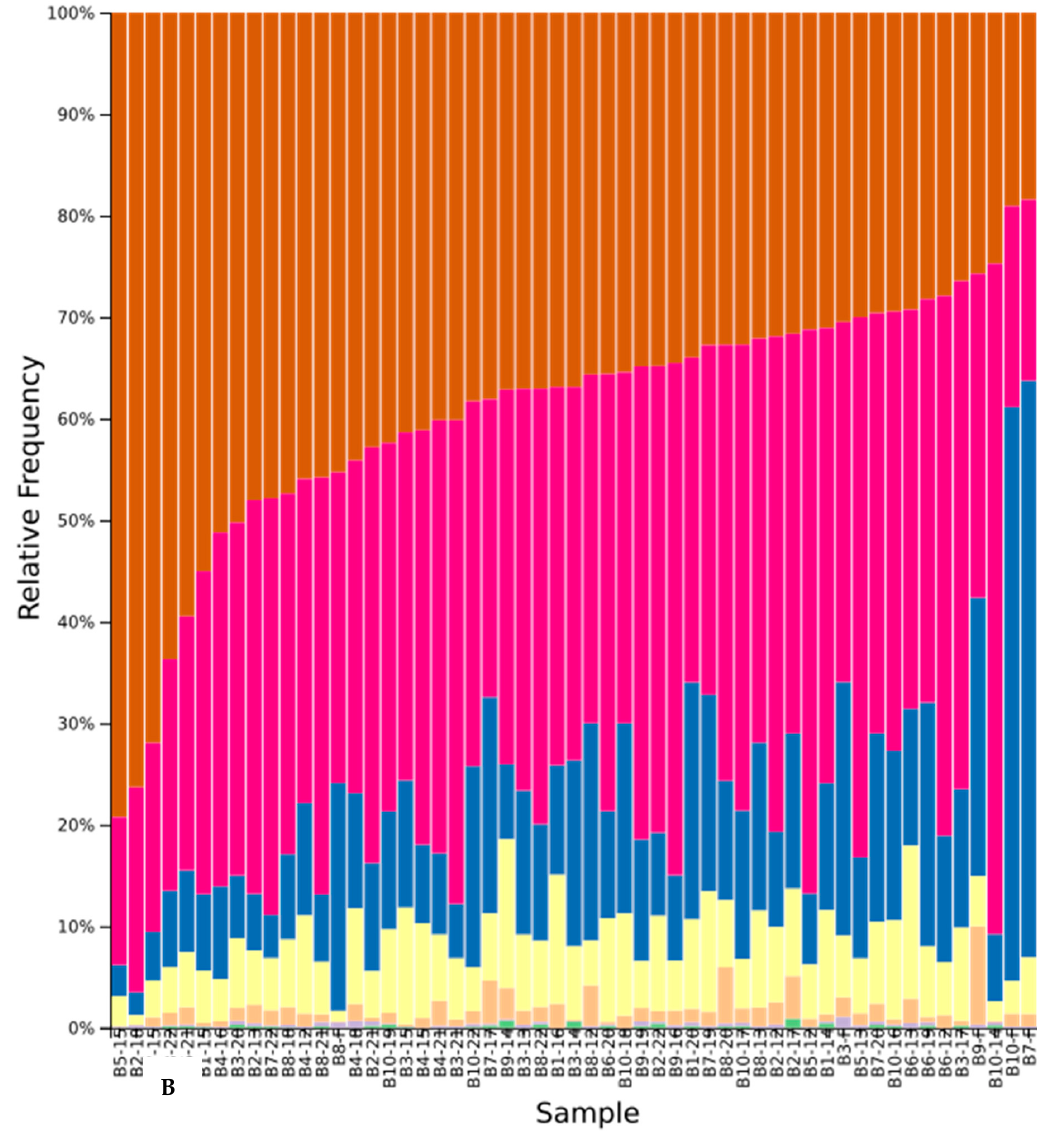
Figure A5. Relative abundance of phyla across native study samples ( A ) and cultivar study samples ( B ) after initial denoising and filtering. Samples are shown with block number followed by treatment number. Numbers 1–4 are white yarrow, Holboell’s rockcress, silky lupine, and bluebunch wheatgrass, respectively while 11 is all native. Numbers 12–15 are white mustard, buckwheat, wheatgrass, and crimson clover, respectively, while 22 and 23 are all cultivar and fallow, respectively. Phyla are Ascomycota (brown), Basidiomycota (pink), Mortierellomycota (yellow), Chytridiomycota (orange), Glomeromycota (purple), and unidentified (blue and